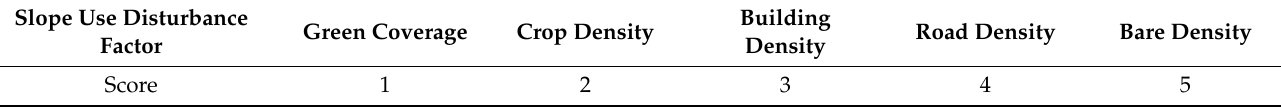
Table 3. Impact scores of slope land use disturbance factors on landslides.